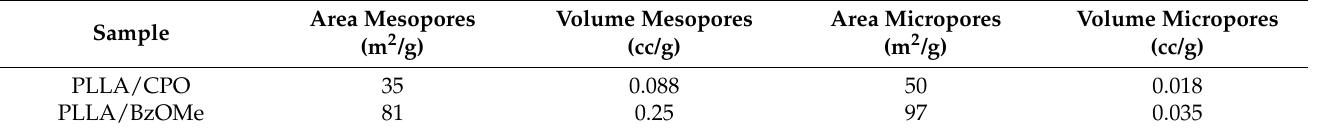
Table 1. Specific surface area and volume of pores by N 2 adsorption–desorption method.